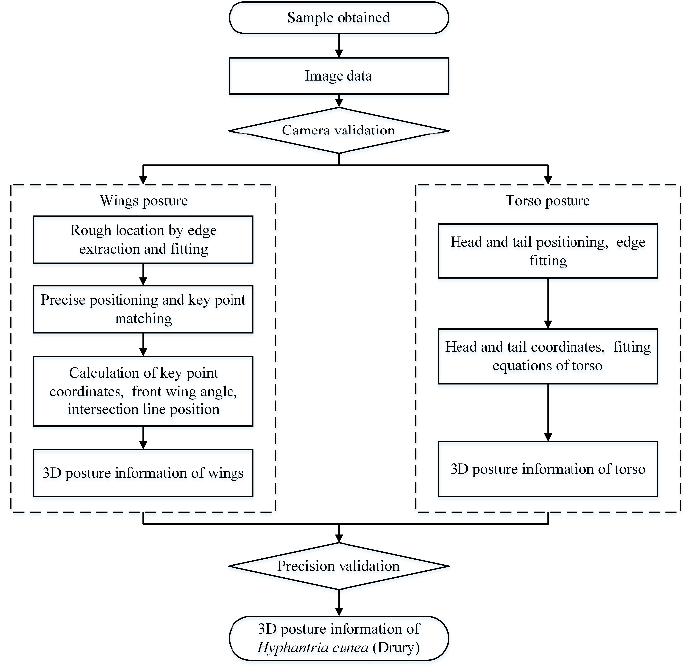
Figure 5. Overall workflow of three-dimensional posture information extraction process of H. cunea. The color image of H. cunea was transformed to a gray image based on the